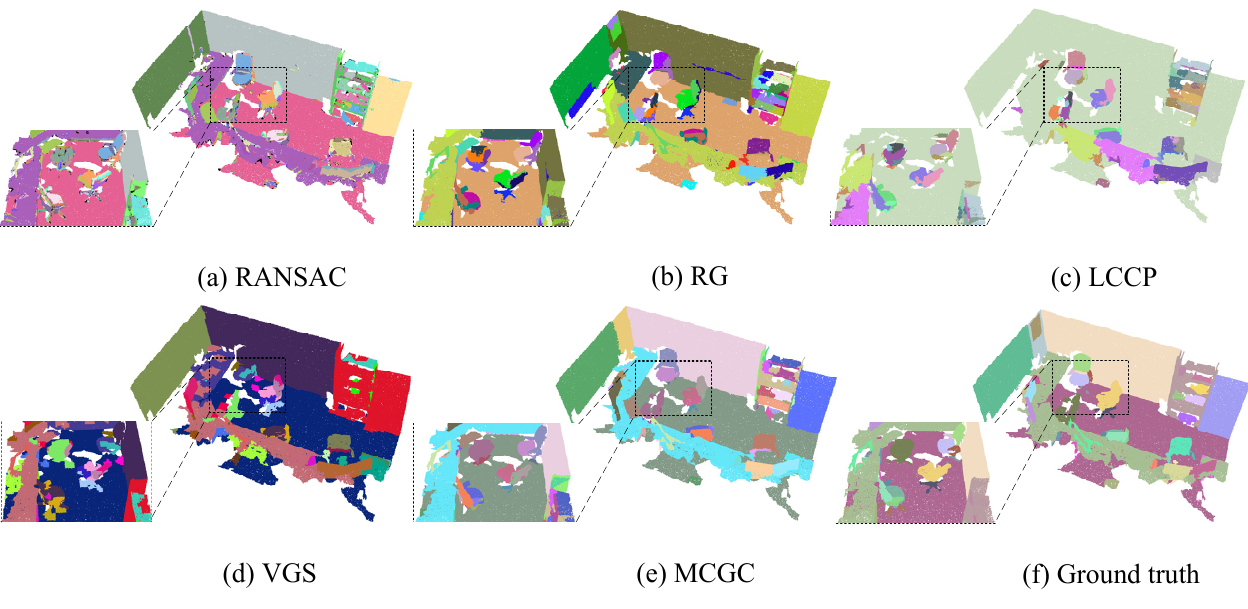
Figure 9. The visual comparison of the office-1 by different methods. One local scene slice which is selected to enlarge the segments in the black box. ( a ) The result from RANSAC. ( b ) The result from RG. ( c ) The result from LCCP. ( d ) The result from VGS. ( e ) The result from MCGC. ( f ) The ground truth.